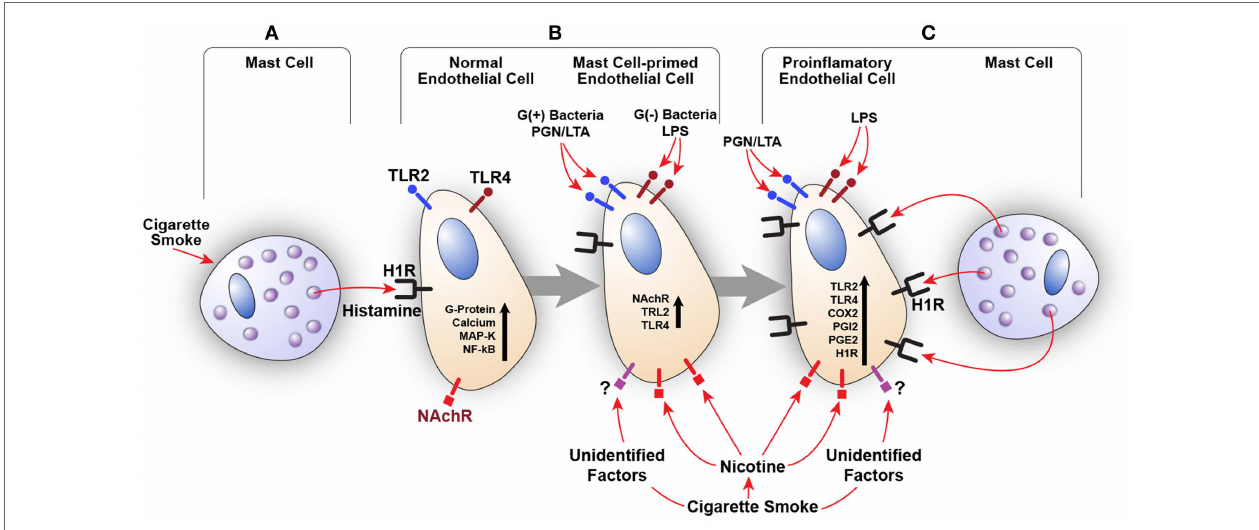
FiGUre 2 | Amplification of endothelial inflammatory response by cigarette smoke (cs) and bacterial products via innate immune upregulation . (A) Histamine secreted by the mast cell stimulates H1R on endothelial cells. CS may also increase histamine release. (B) H1R-mediated endothelial cell activation leads to increased expression of TLR2/TLR4 and nicotinic acetylcholine receptors (NAChR). This cross talk programs endothelial cells to become hyperresponsive to the TLR2/TLR4 ligands (PGN, LTA, and LPS) and CS leading to enhanced inflammatory response. (c) Increased TLR2/TLR4 signaling also increases H1R expression. Collective stimulation of newly expressed TLR2/TLR4 and H1R leads to robust proinflammatory changes in the endothelium and persistent vascular